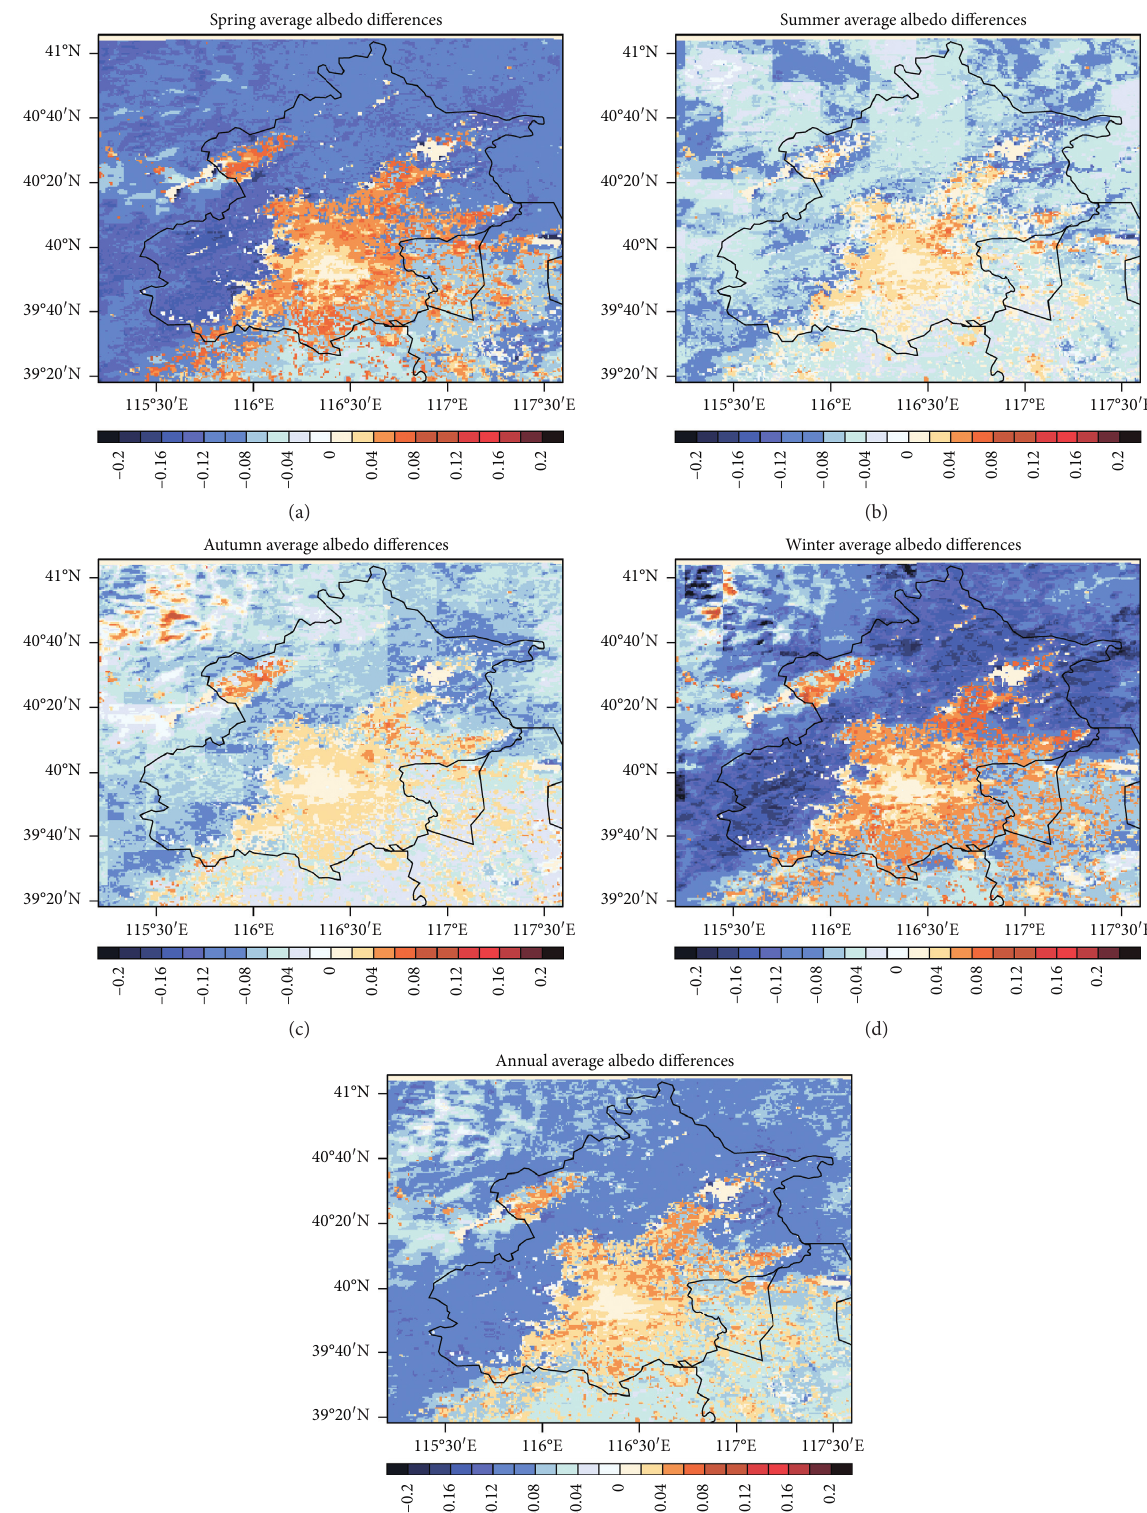
Figure 5: Spatial distribution of the annual (e) and seasonal (a–d) average surface albedo simulation differences before and after assimilation in the Beijing municipal area (after assimilation minus before